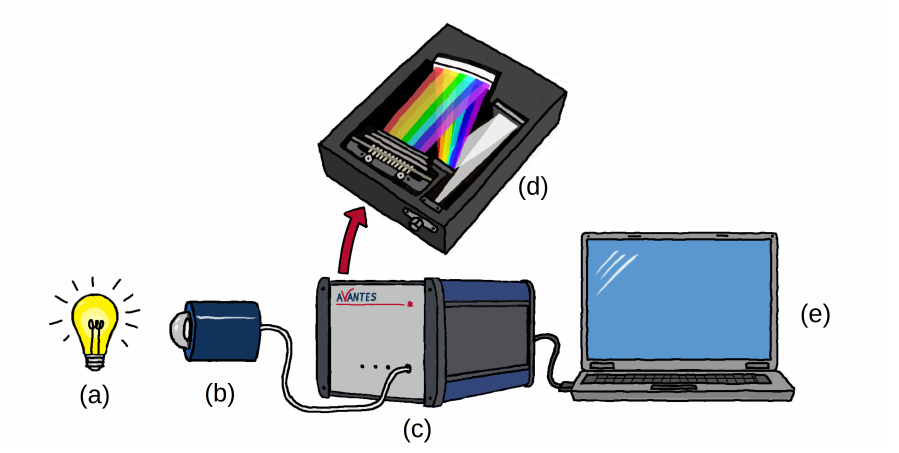
Figure 2. Schematic diagram of the equipment: ( a ) light source (e.g., calibration lamp or the sun) to be measured; ( b ) diffuser, enclosed in its case; ( c ) spectrometer case, which includes ( d ) monochro- mator/optical bench (figure adapted from